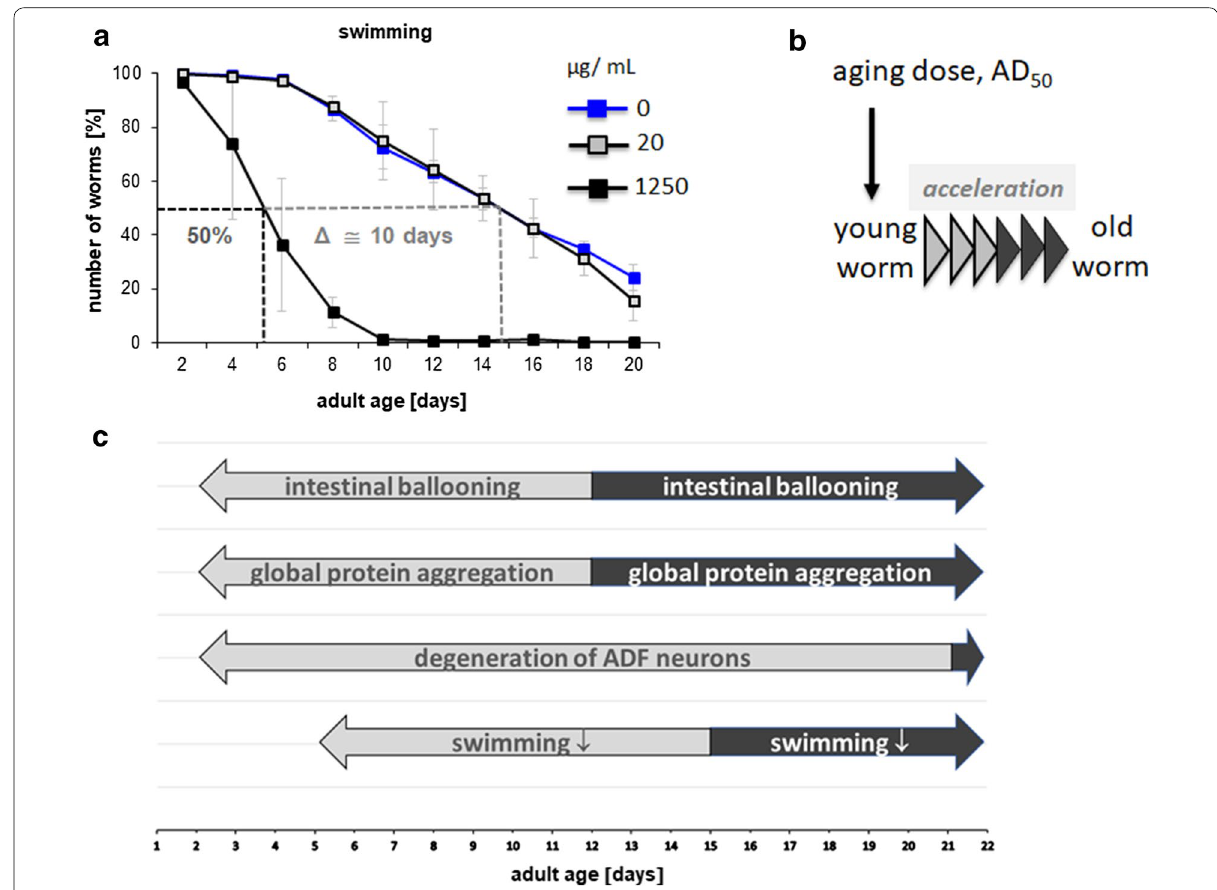
(nano-silica). The locomotion phenotype of swimming was measured over the entire life span of the worms. Adult age is given in days ( x -axis) and plotted against the number of worms showing the phenotype ( y -axis). The effect of the pollutant was estimated using two representative concentrations (20 and 1250 μg/mL). Only 1250 μg/mL is effective and thus an aging dose (AD) 50 that represents the concentration in which 50% of the worms already show a specific age-related defect, while the other half still exhibit the normal phenotype. Notably, exposure to 1250 μg/ mL nano-silica accelerates the cessation of swimming in 50% of the worms by 10 days, e.g., from 15-day-old worms to 5-day-old worms (dotted lines). Values represent mean SD from three independent experiments with n 121–162 worms per condition per experiment. b Schematic: ± = the aging dose (AD) 50 indicates any concentration of a pollutant that accelerates aging of a young worm concerning an age-related phenotype. c Representative for certain other pollutants nano-silica accelerates organismal aging that manifests in biochemical, morphological and neurobehavioral phenotypes. Life span-resolved analyses reveal that hallmarks of aging (black arrows) occur prematurely (light gray arrows), as early as on day 2, in wild-type C. elegans exposed to silica nanoparticles [10, 14, 15] (Additional file 1: Table